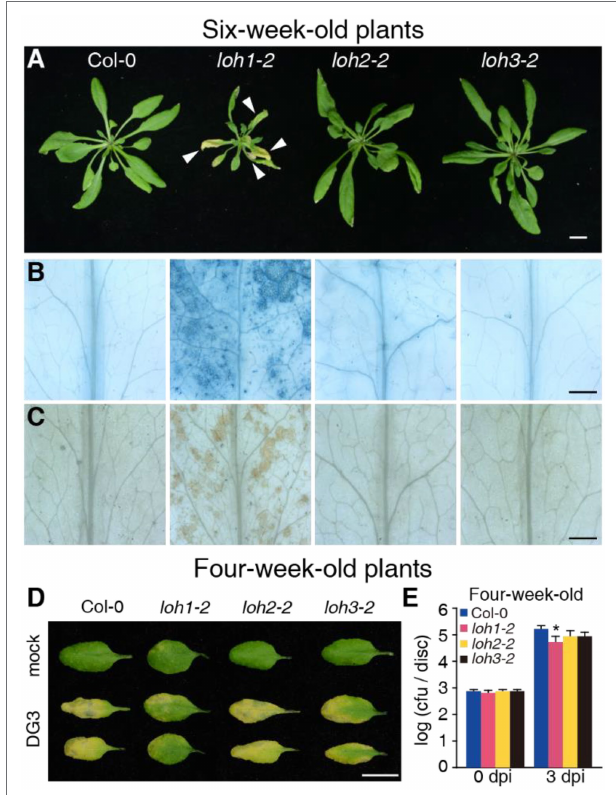
FIGURE 5 | Defense responses of Col-0, loh1-2 , loh2-1 , and loh3-2 plants. (A) Growth phenotypes of 6-week-old plants (inflorescence stems were removed before we photographed the plants). Bar = 1 cm. White arrowheads indicate cell death lesions. (B) Trypan blue staining of leaves from (A) . Bar = 1 mm. (C) 3,3 ′ -diaminobenzidine (DAB) staining of leaves from (A) . Bar = 1 mm. (D) The rosette leaves from 4-week-old plants were inoculated with Psm DG3, and the pictures of leaves were taken 3 days after inoculation. Bar = 1 cm. (E) Growth of Psm DG3 in leaves from 4-week-old plants in (D) . Trypan blue (B) and DAB staining (C) of untreated leaves. At least 12 leaves per line were stained each time in (B,C) , and at least 30 plants per line were tested each time in (D,E) . Values are means ± SE from six biological replicates at 0 days post-infection (dpi) and 24 biological replicates at 3 dpi in (E) . Significant differences between Col-0 and loh1-2 , loh2-2 , or loh3-2 were determined by Student’s t -test (* p < 0.05) in (E) . The experiments were conducted three times